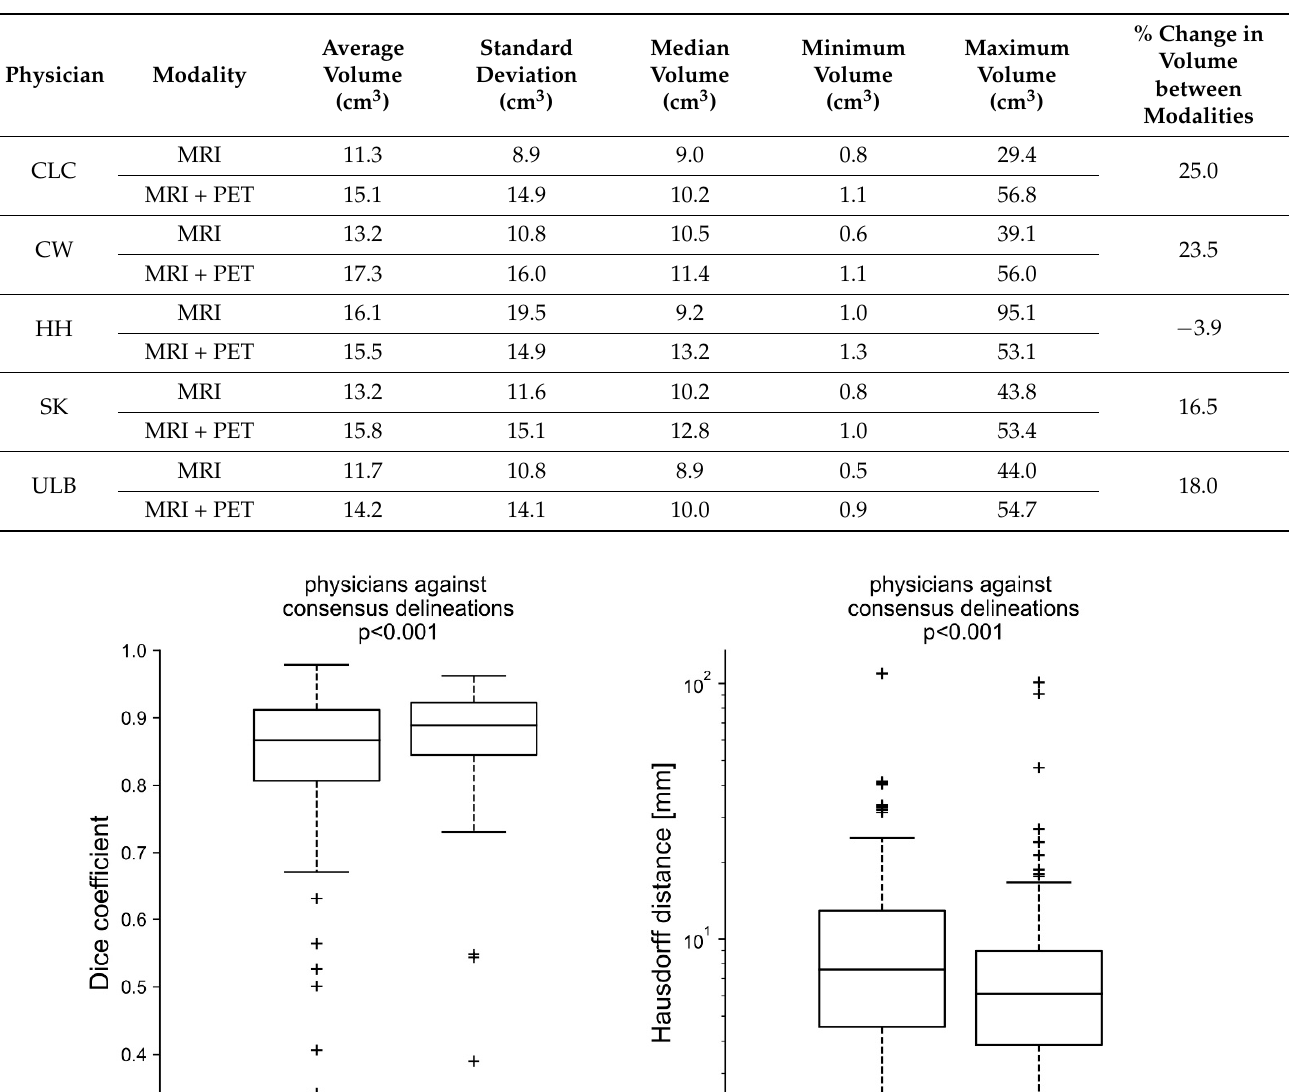
Table 2. Summary of the volumes of the delineations by the respective physicians. The percentage change in volume between the delineations based solely on MRI and MRI + PET images is given in the last column.